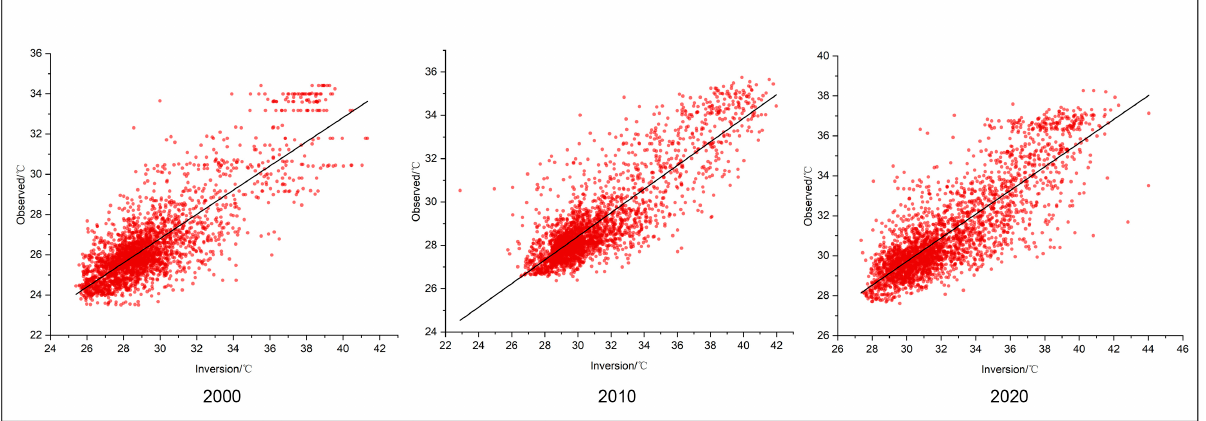
Figure 3. Linear fi tt ing results. Figure 3. Linear fitting results.